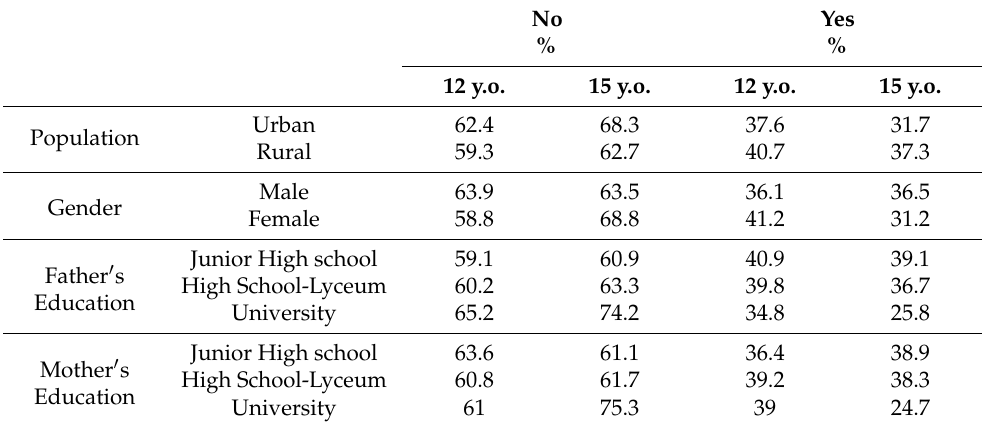
Table 7. Orthodontic treatment need using the modified IONT Index.